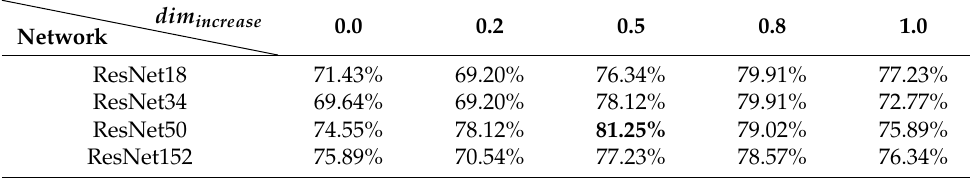
Table 4. Accuracy of the validation set with different combinations of network architecture and dim increase parameter for a dataset with human